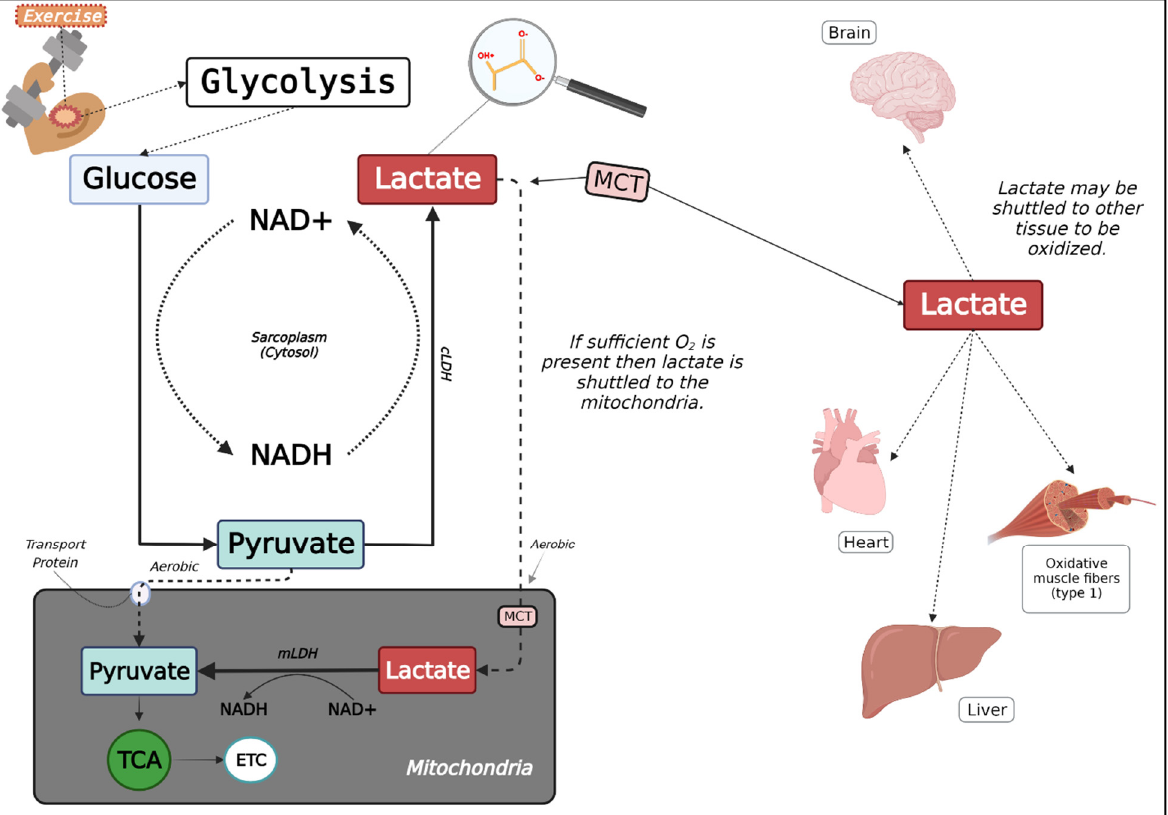
Figure 1. Lactate Metabolism and Shuttle. NAD+/NADH = Nicotinamide adenine dinucleotide (NAD) + hydrogen (H); MCT = monocarboxylate transporter; cLDH = Cytosol lactate dehydrogenase; mLDH = Mitochondrial lactate dehydrogenase; TCA = Tricarboxylic acid cycle; ETC = Electron transport chain. Created with BioRender.com.